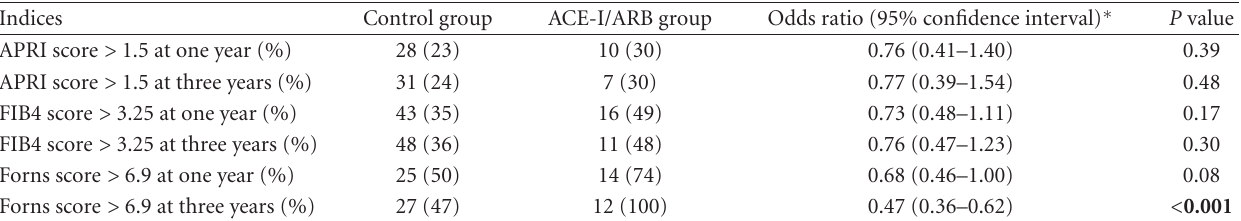
Forns score > 6.9 at three years (%)